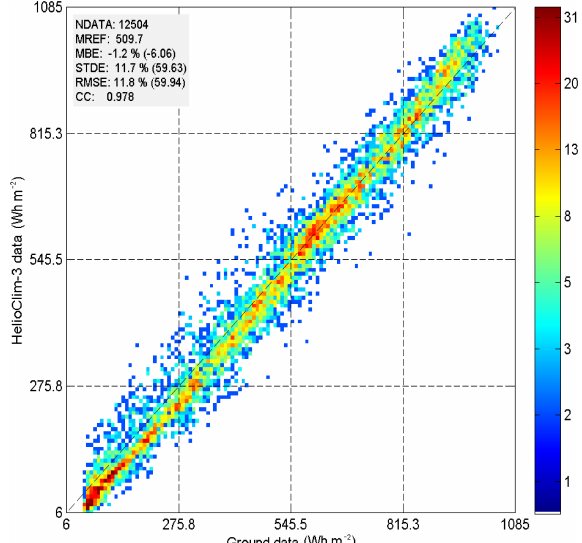
Figure 2. 2-D histogram of the in situ measurements (horizontal axis) and HC3v4 estimates (vertical axis) at Erfoud. The number of samples (NDATA), the mean of the measured hourly irradia- tions (MREF), the bias (MBE), the standard-deviation (STDE), root mean square of the errors (RMSE) in Whm − 2 , and the correlation coefficient (CC) are reported in the upper left corner. Relative val- ues are obtained by the division of the quantity by MREF.